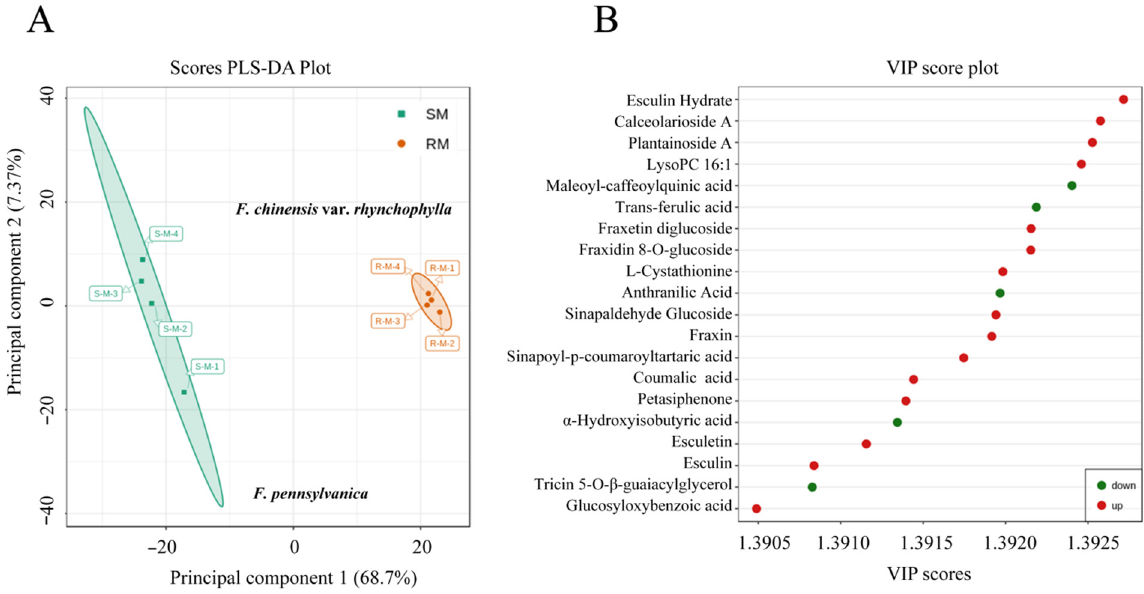
Figure 2. The PLS-DA score scatter plot of metabolites detected in F. chinensis var. rhynchophylla and F. pennsylvanica ( A ), and the top 20 differential metabolites with the largest VIP values ( B ). S-M-1, S-M-2, S-M-3, and S-M-4 represent four replicates of susceptible F. pennsylvanica , and R-M-1, R-M-2, R-M-3, and R-M-4 represent four replicates of resistant F. chinensis var. rhynchophylla